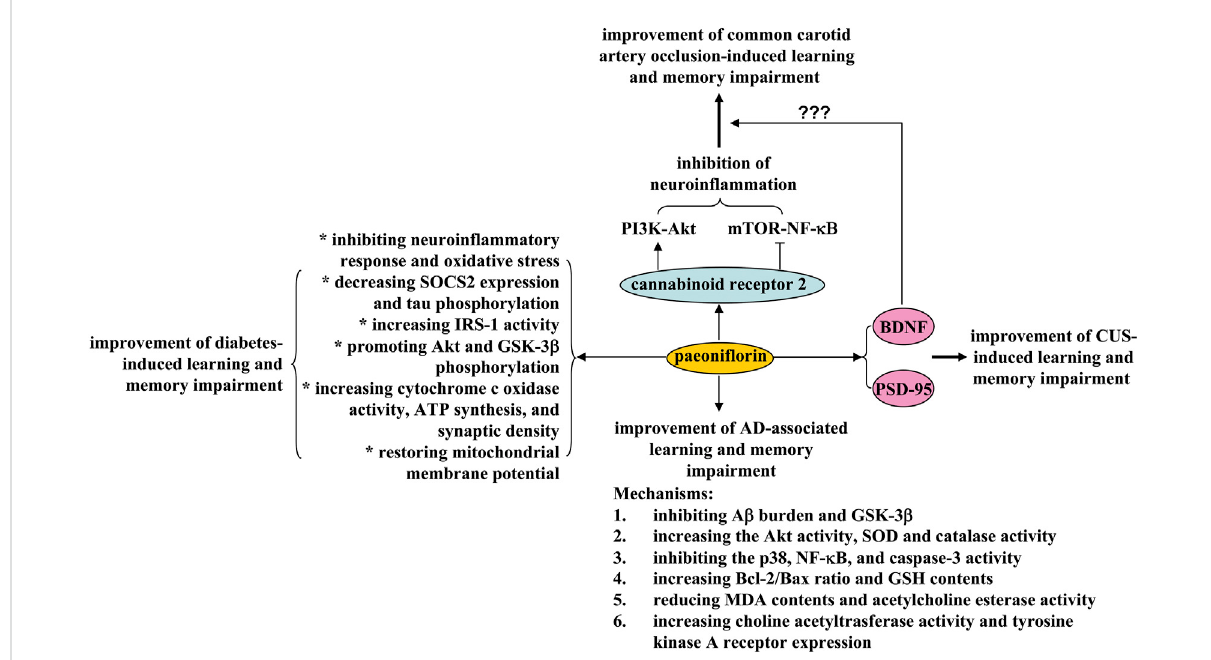
FIGURE 3 Effects and mechanisms of paeoni fl orin on learning and memory impairment. Paeoni fl orin administration may ameliorate 1) learning and memoryimpairmentinducedbycommoncarotidarteryocclusionbyinhibitingneuroin fl ammationinacannabinoidreceptor2-dependentmanner; paeoni fl orin-triggered activation of cannabinoid receptor 2 induces activation of PI3K-Akt signaling and inhibition of mTOR-NF- κ B signaling, thereby improving learning and memory impairment induced by carotid artery occlusion, 2) diabetes-induced learning and memory impairment by inhibiting neuroin fl ammation and oxidative stress, decreasing SOCS2 expression and tau phosphorylation, increasing IRS-1 activity, promoting Akt and GSK-3 β phosphorylation, increasing cytochrome c oxidase activity, ATP synthesis, and synaptic density, and restoration of mitochondrial membrane potential, 3) Alzheimer ’ s disease-associated learning and memory impairment by inhibiting A β burden and GSK-3 β , increasing the Akt activity, SOD and catalase activity, inhibiting p38, NF- κ B and caspase-3 activity, increasing Bcl-2/Bax ratio and GSH